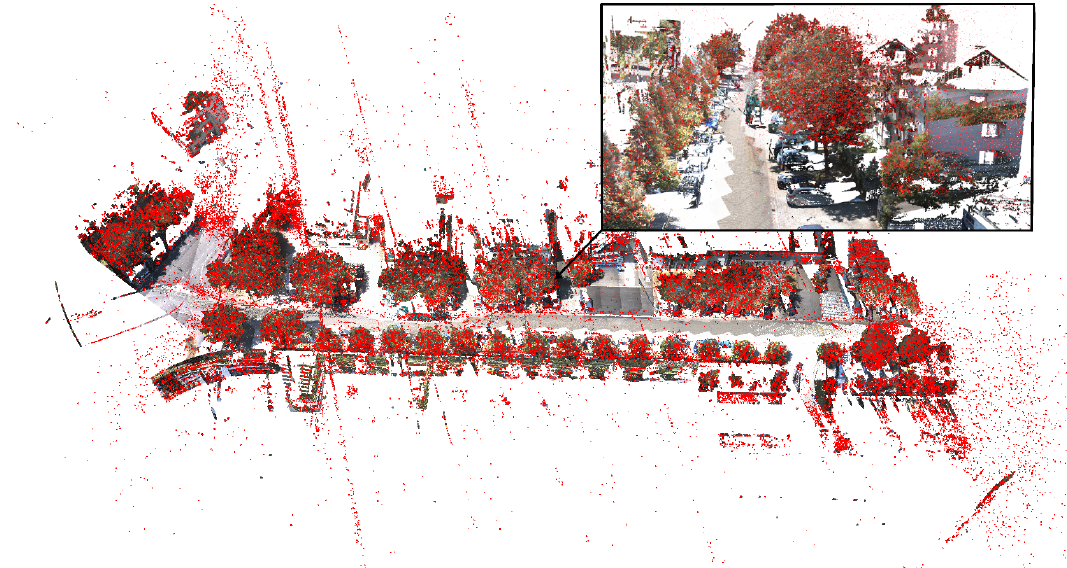
Figure 6. Noise illustration in red on the point cloud acquired by the mobile mapping